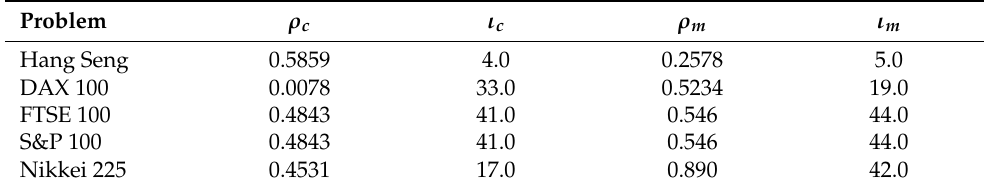
Table 4. Optimal control parameter values for the strength pareto evolutionary Algorithm 2.